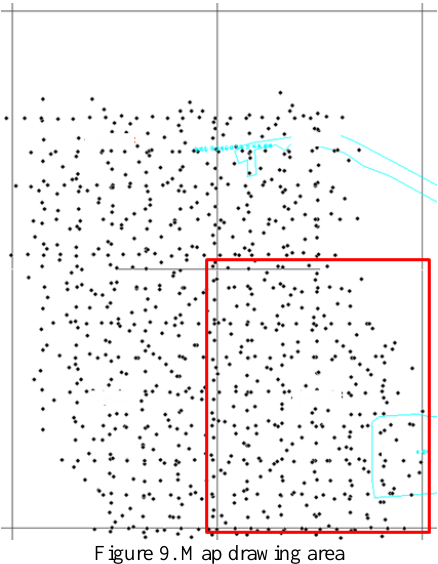
Figure 9. Map drawing area